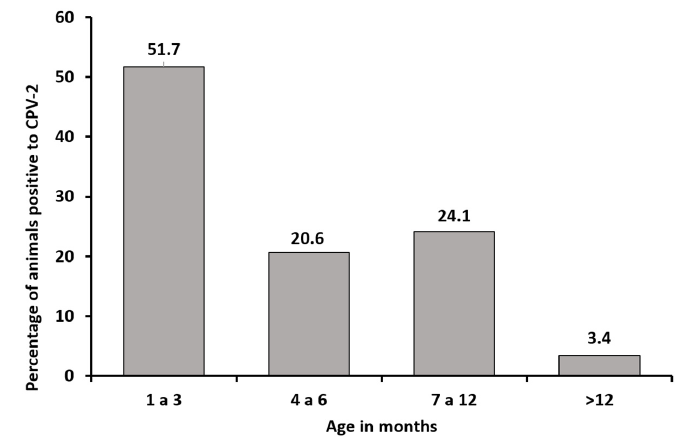
Figure 1. Distribution of CPV-2-positive samples by animal’s age (in months).